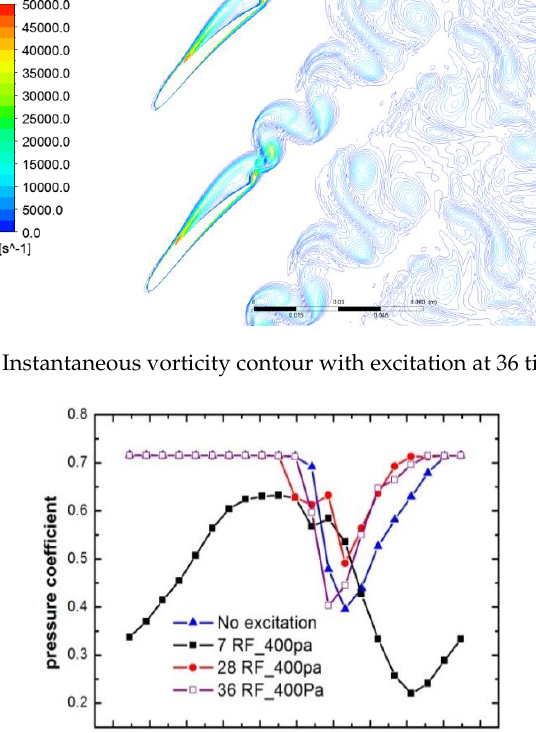
Figure 15. Pressure loss comparison with and without excitations.